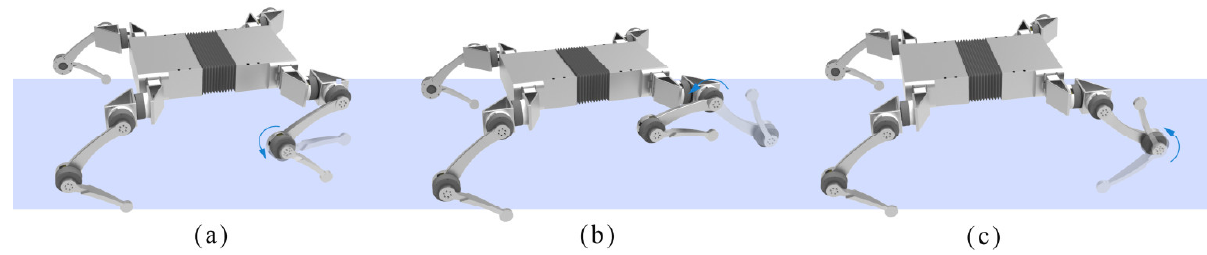
Figure 9. Motion diagram of left hind leg: mammal form to reptile form: ( a ) Actuator 4 drives the calf to approach the thigh; ( b ) Actuator 3 drives the thigh and calf to move together; ( c ) Actuator 4 drives the calf to touch the ground.